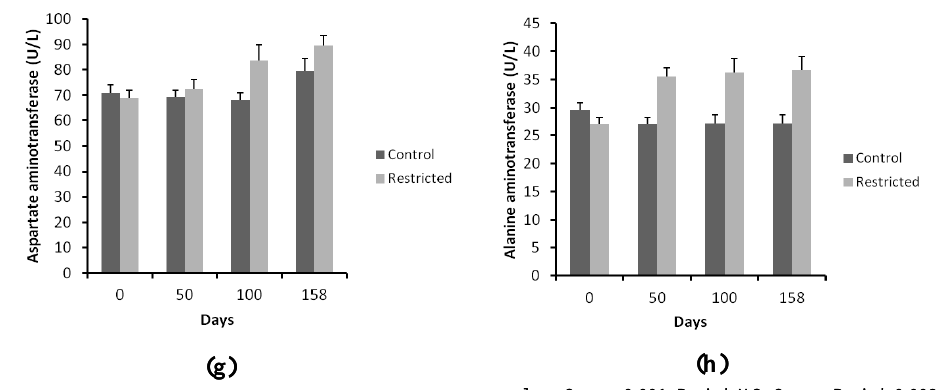
Figure 2. ii) Effect of limited concentrate feeding on plasma levels of triglycerides (e), amylase (f), aspartate aminotransferase (g), and alanine aminotransferase (h). NS, not